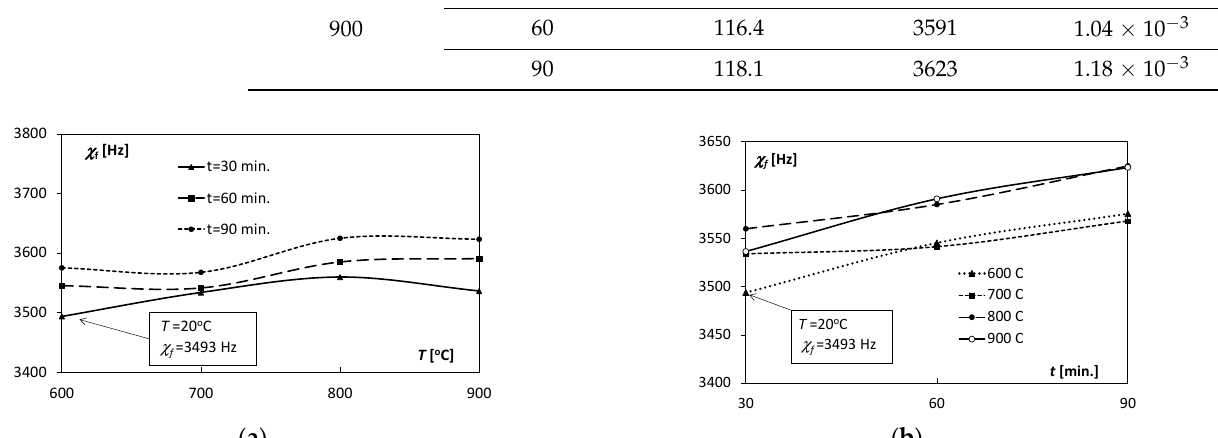
Figure 2. Variations of values of Young’s modulus E of the Ti/Cu bimetal dependent on: ( a ) temper- ature T , ( b ) annealing time t .